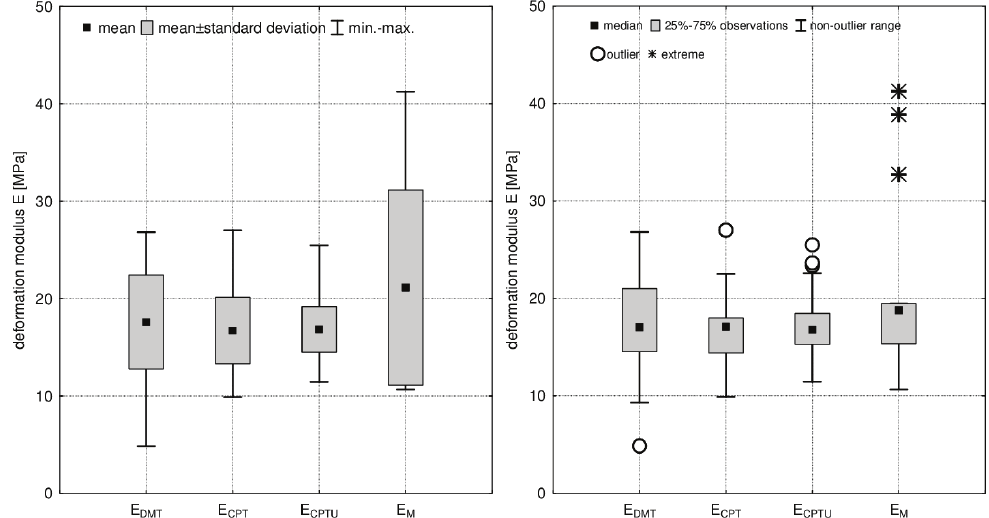
Fig. 5. Statistical comparison of deformation modulus based on in situ tests